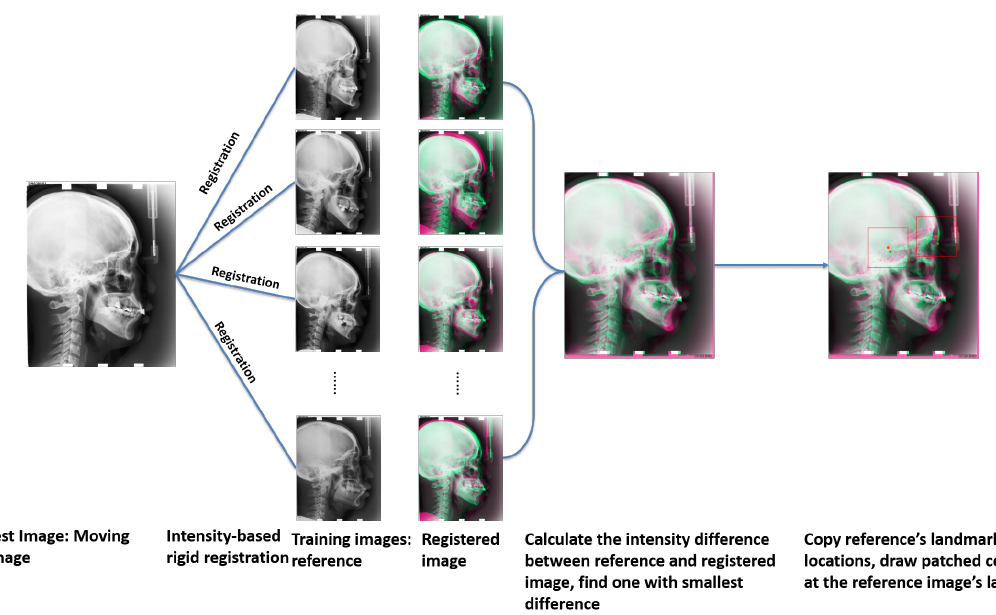
Figure 6. The architecture of Automatic